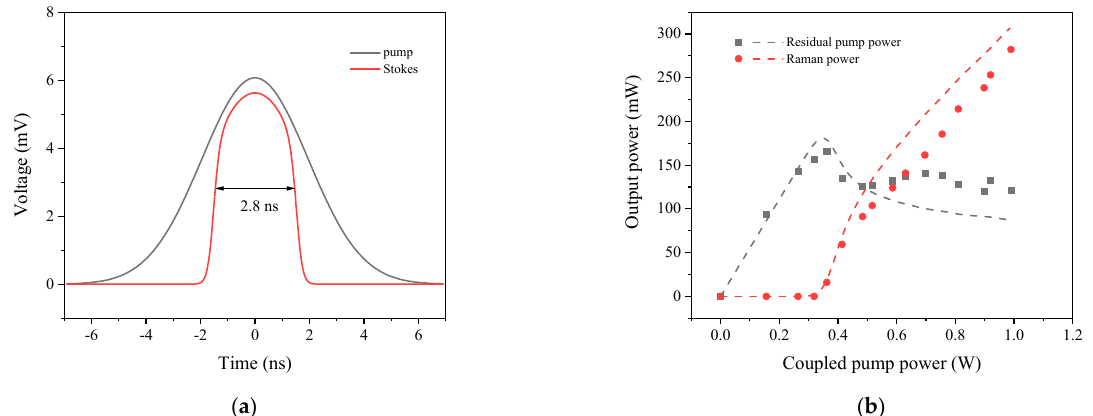
Figure 10. The simulation results of ( a ) the pump pulse shape and the first-order Stokes pulse shape and ( b ) the output power characteristics.